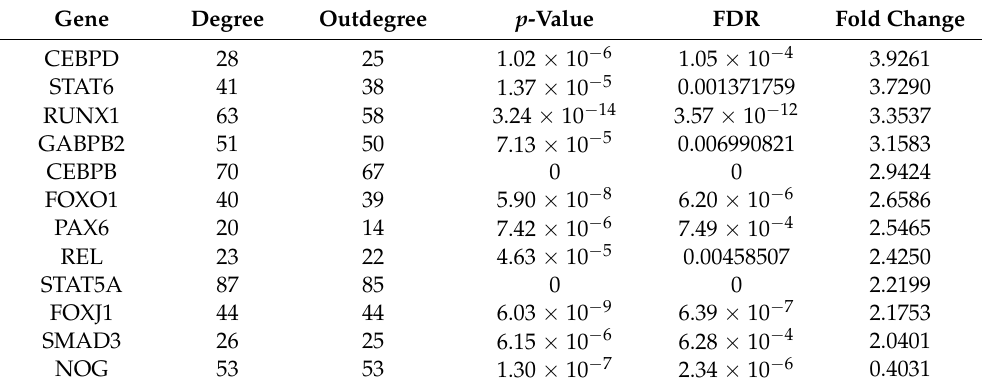
Table 1. Important regulatory factors in pathogenesis of